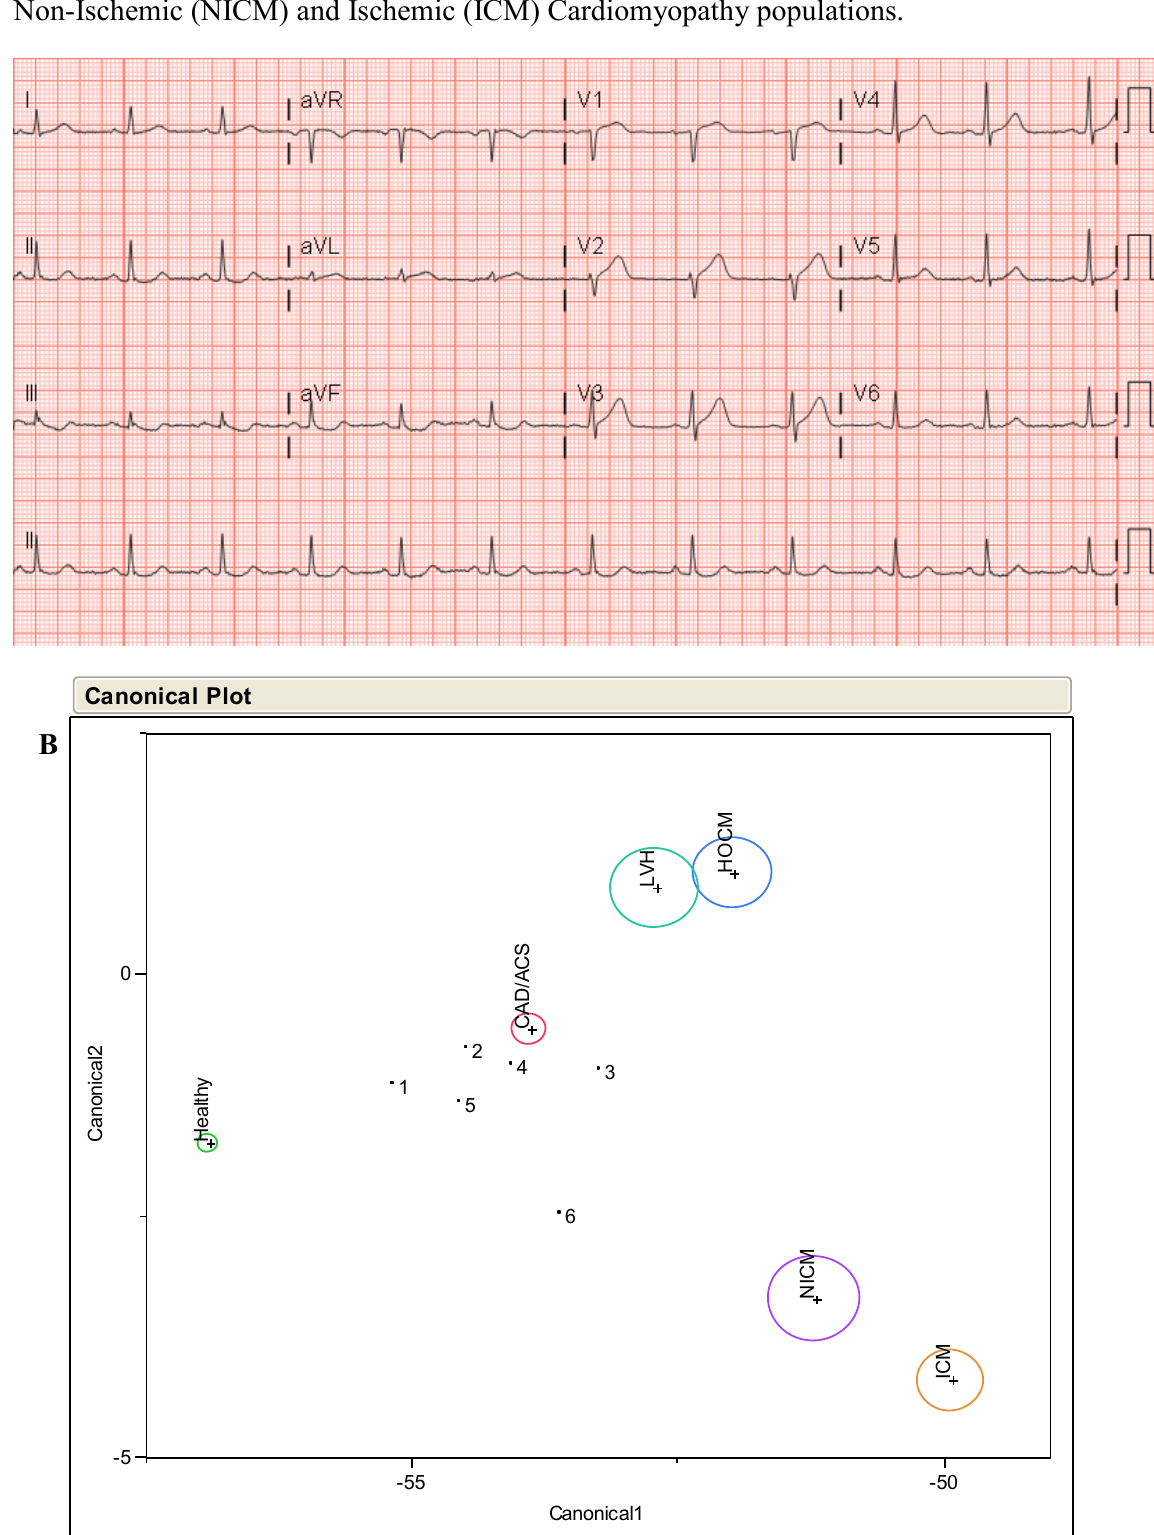
Figure 10. Conventional ECG for Case 1 ( A ); ( B ) A-ECG-related discriminant analysis results for six serial ECGs in Case 1 using multiple advanced ECG parameters. Red circle = Coronary Artery Disease and/or Acute Coronary Syndrome (CAD/ACS) population; Aqua circle = Left Ventricular Hypertrophy (LVH) population; Blue circle = Hypertrophic Cardiomyopathy (HOCM) population; Purple and Orange circles = Non-Ischemic (NICM) and Ischemic (ICM) Cardiomyopathy